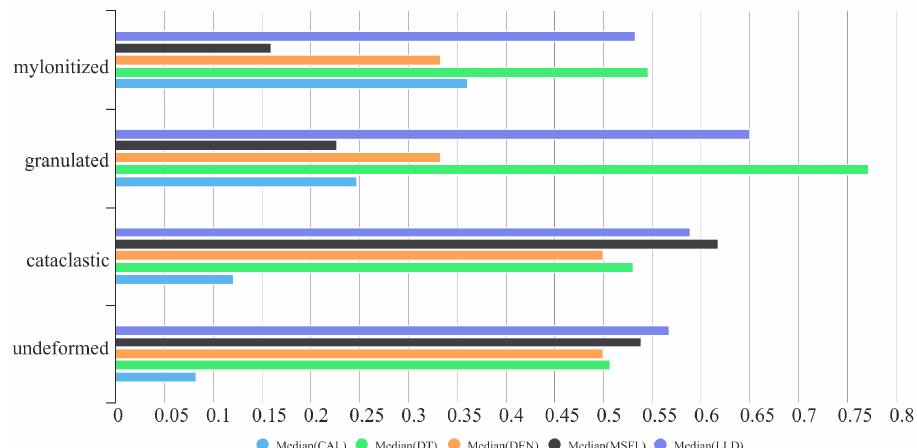
Figure 5. The normalized value horizontal bar of logging data with different TDC.